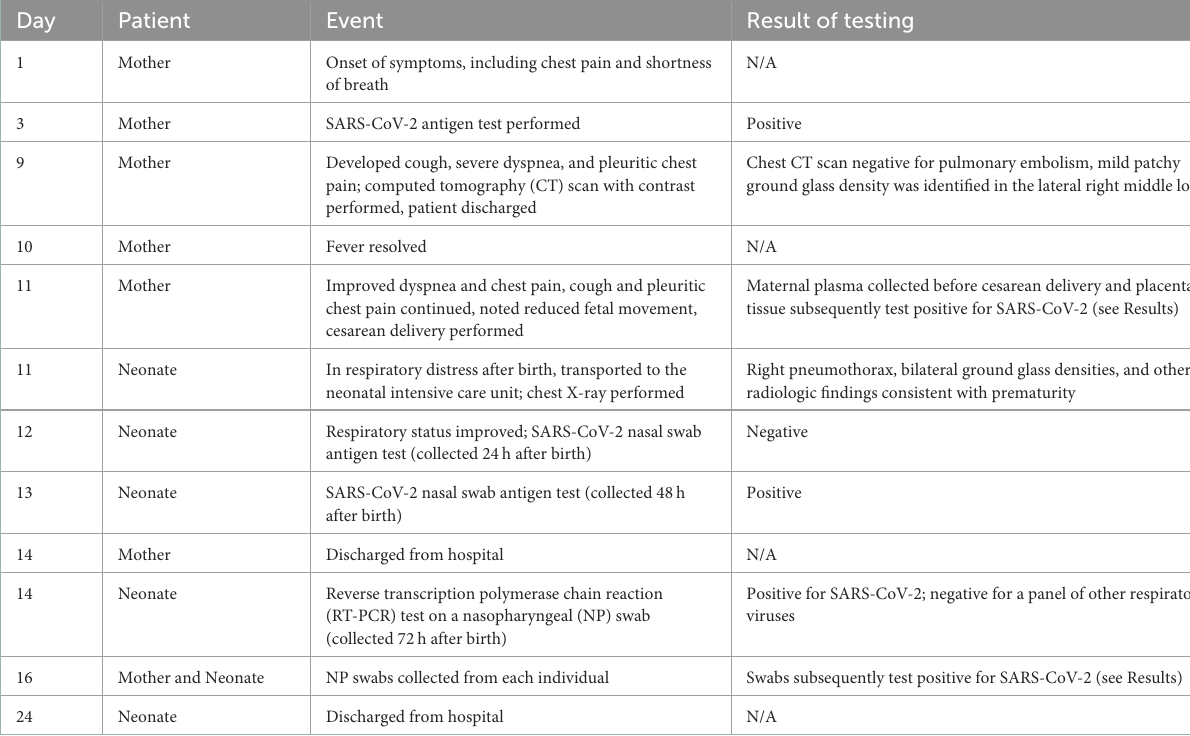
TABLE 1 Case timeline: Maternal and neonatal symptom development, clinical care, and sample